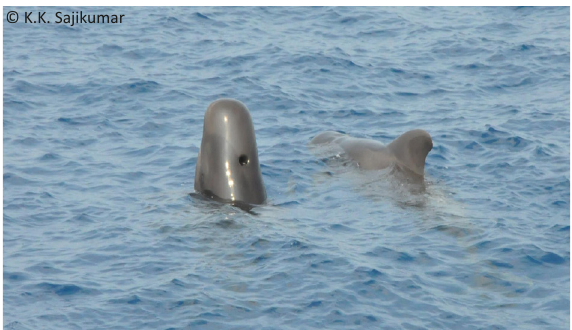
Image 5. The whale showing spyhopping